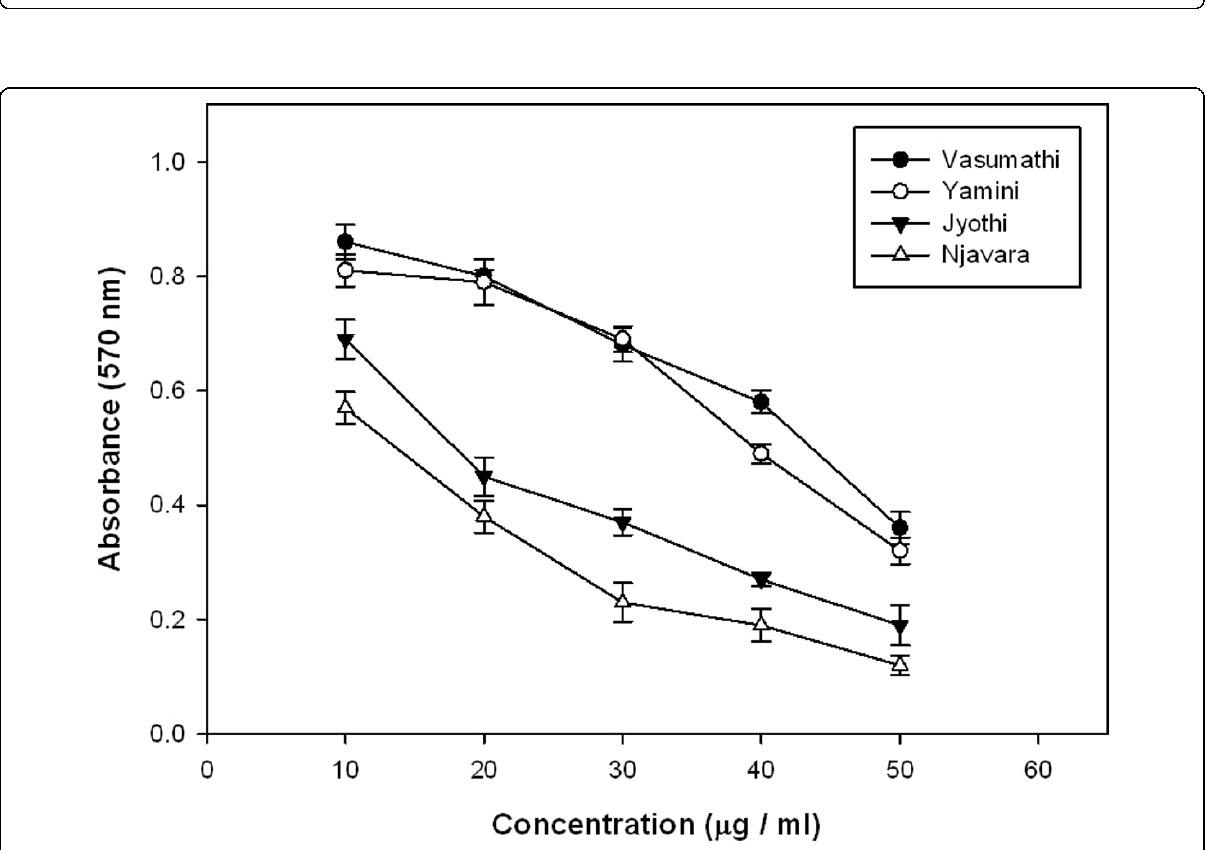
Figure 4 Nitric oxide scavenging activity (%) . NO scavenging activity in the methanolic rice bran extracts from four rice cultivars. Results represent means ± standard deviation (n = 3).